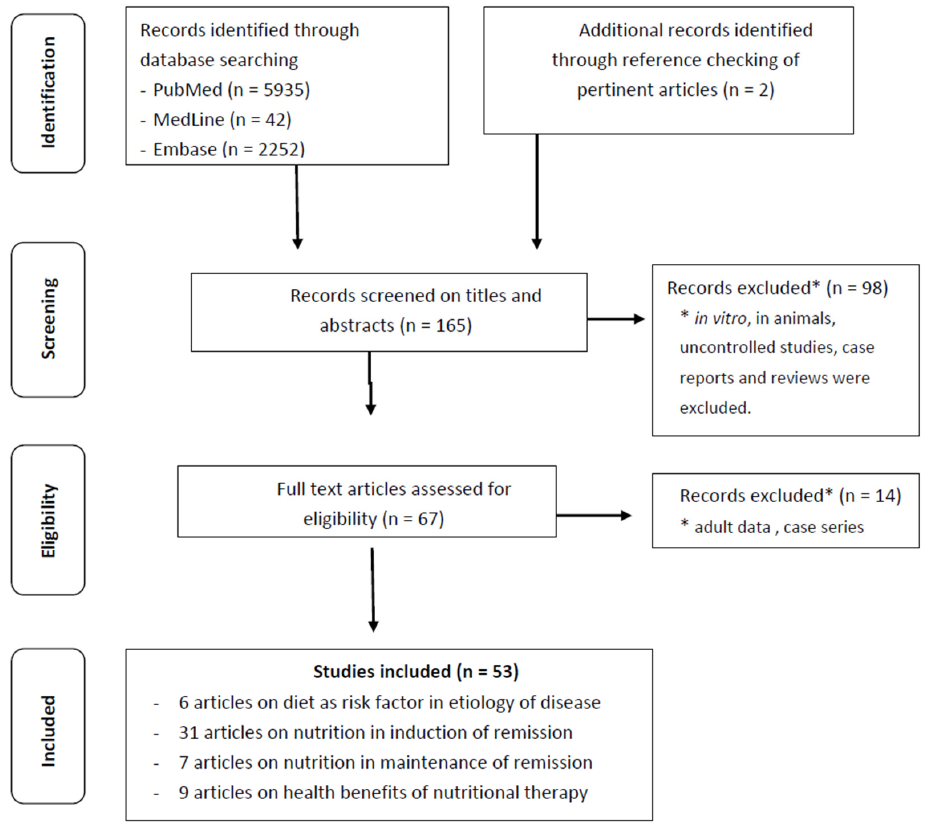
Figure 1. Flow ‐ chart on the methods of the systematic review. Figure 1. Flow-chart on the methods of the systematic